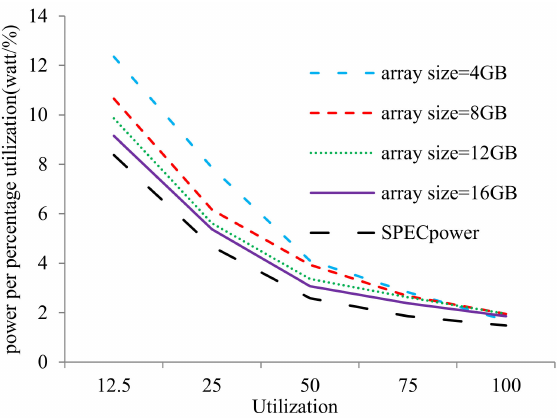
Figure 14. Power per percent utilization of server #2 running SPECpower and STREAM benchmark (CPU frequency at 1.2